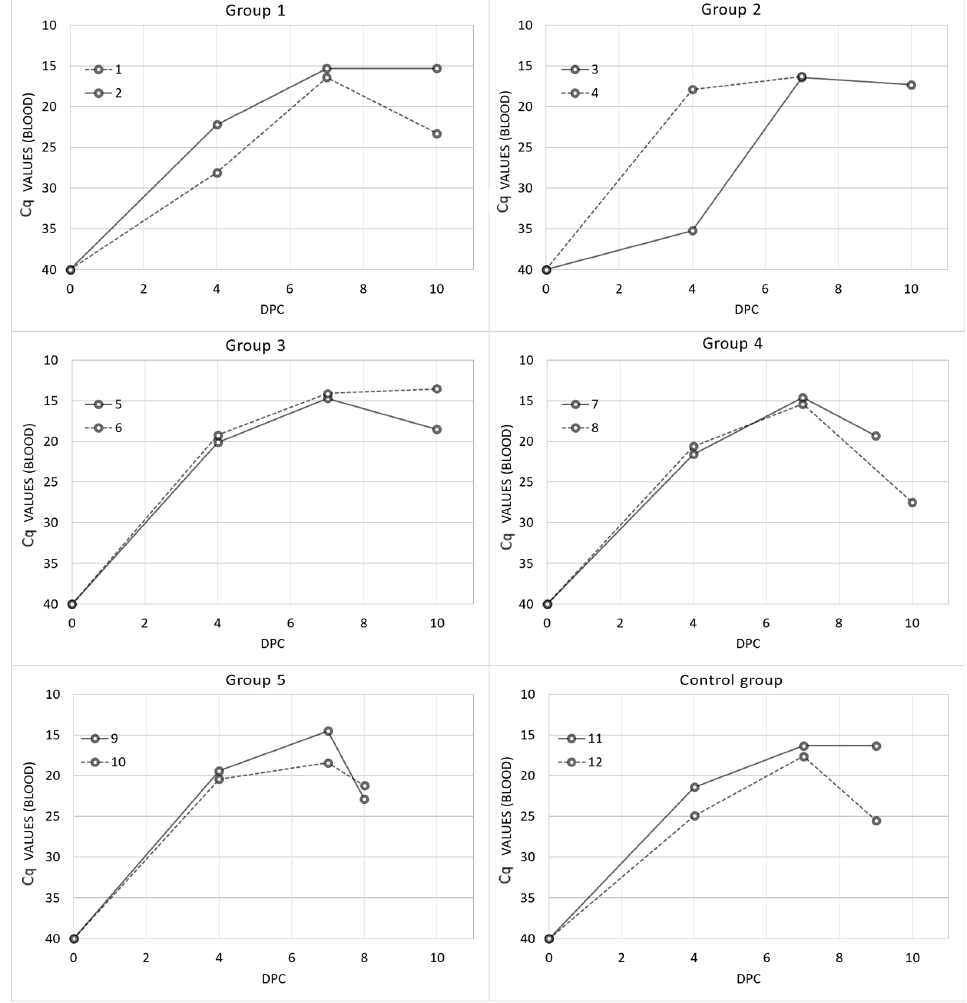
Figure 3. Individual post-challenge viremia results expressed in qPCR cycles of quantification values (C q ) of domestic pigs from the different vaccinated groups: Group 1 (Pol16-inactivated, MF59), Group 2 (Pol16-inactivated, Silica oil), Group 3 (Pol16-inactivated, mGNE), Group 4 (Pol16-inactivated, Montanide ISA201), Group 5 (Pol16-inactivated), and the control group.